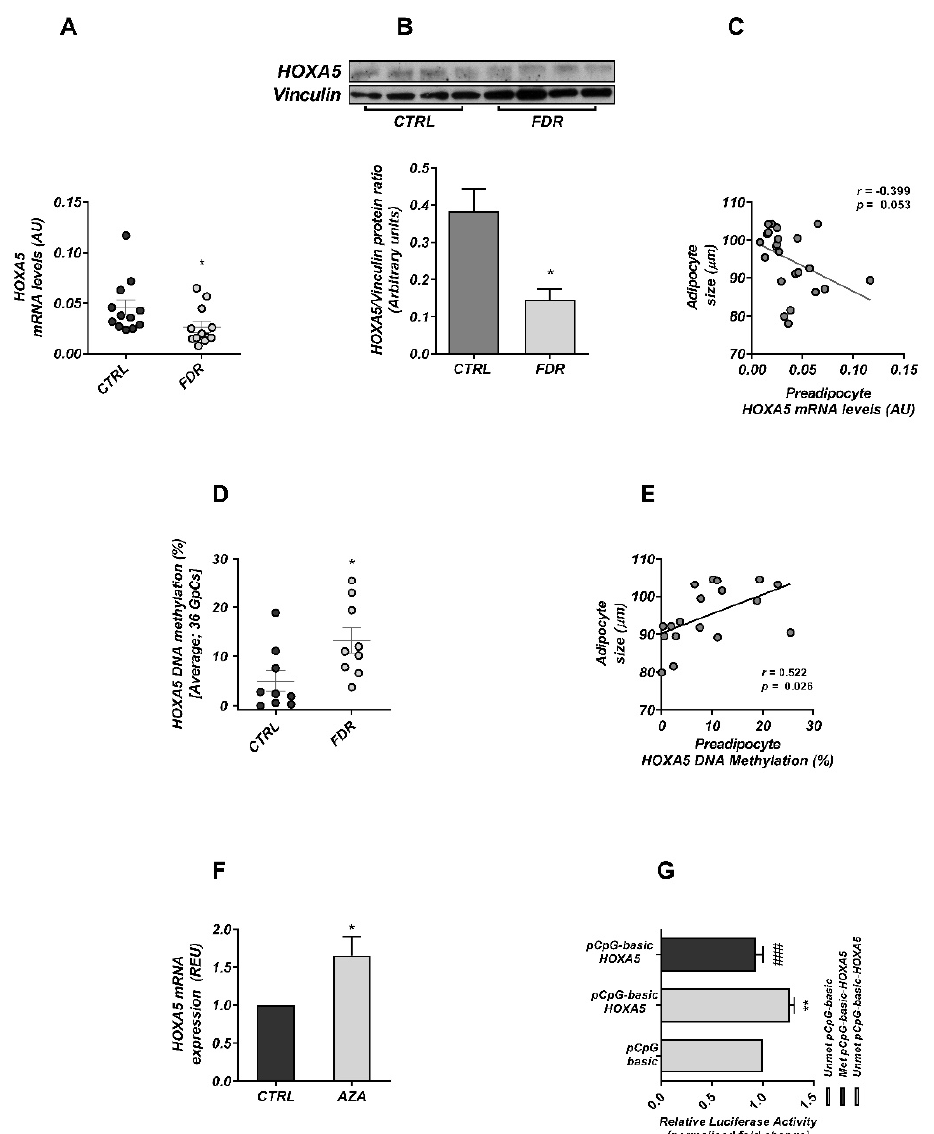
Figure 2. HOXA5 mRNA expression and DNA methylation in preadipocytes and correlation with the cell size of mature subcutaneous adipocytes from FDR and CTRL subjects. ( A ) The HOXA5 mRNA expression was measured by qPCR in preadipocytes from FDR (n = 12) and control (CTRL; n = 12) subjects as described in the Materials and Methods section. Data points represent absolute units (AU) from each individual subject. ( B ) HOXA5 protein levels were assessed by WB in preadipocytes from FDR (n = 4) and CTRL (n = 4) subjects available from the study group. Mean values ± SD are also shown. * p < 0.05 in a two-tailed Mann–Whitney U-test. ( C ) The correlation between the preadipocyte HOXA5 mRNA levels and adipose cell size was assessed in FDR (n = 12) and CTRL (n = 12) subjects. The r correlation coefficient and p -value are indicated in the graph. ( D ) Changes in average DNA methylation levels at 36 CpG within the HOXA5 promoter were detected by BS in preadipocytes from FDR (n = 9) and CTRL (n = 9) subjects available from the study group. Mean values ± SD are also shown. * p < 0.05 in two-tailed Mann–Whitney U-test. ( E ) Correlation between preadipocyte HOXA5 DNA methylation and mature adipose cell size in FDR (n = 9) and CTRL (n = 9) subjects. The r correlation coefficient and p -value are indicated in the graph. Effect of DNA methylation on HOXA5 transcriptional activity. ( F ) HOXA5 mRNA expression levels in preadipocytes maintained in the absence (CTRL) or the presence of 5 ′ AZA (AZA), as described in the Materials and Methods section, were analyzed by qPCR and normalized to RPL13 . Results are expressed as the mean ± SD of n = 3 independent experiments. * p < 0.05 in a two ‐ tailed Student’s t ‐ test. ( G ) A CpG ‐ free basic plasmid with a luciferase reporter gene (pCpG ‐ basic), where the HOXA5 minimal